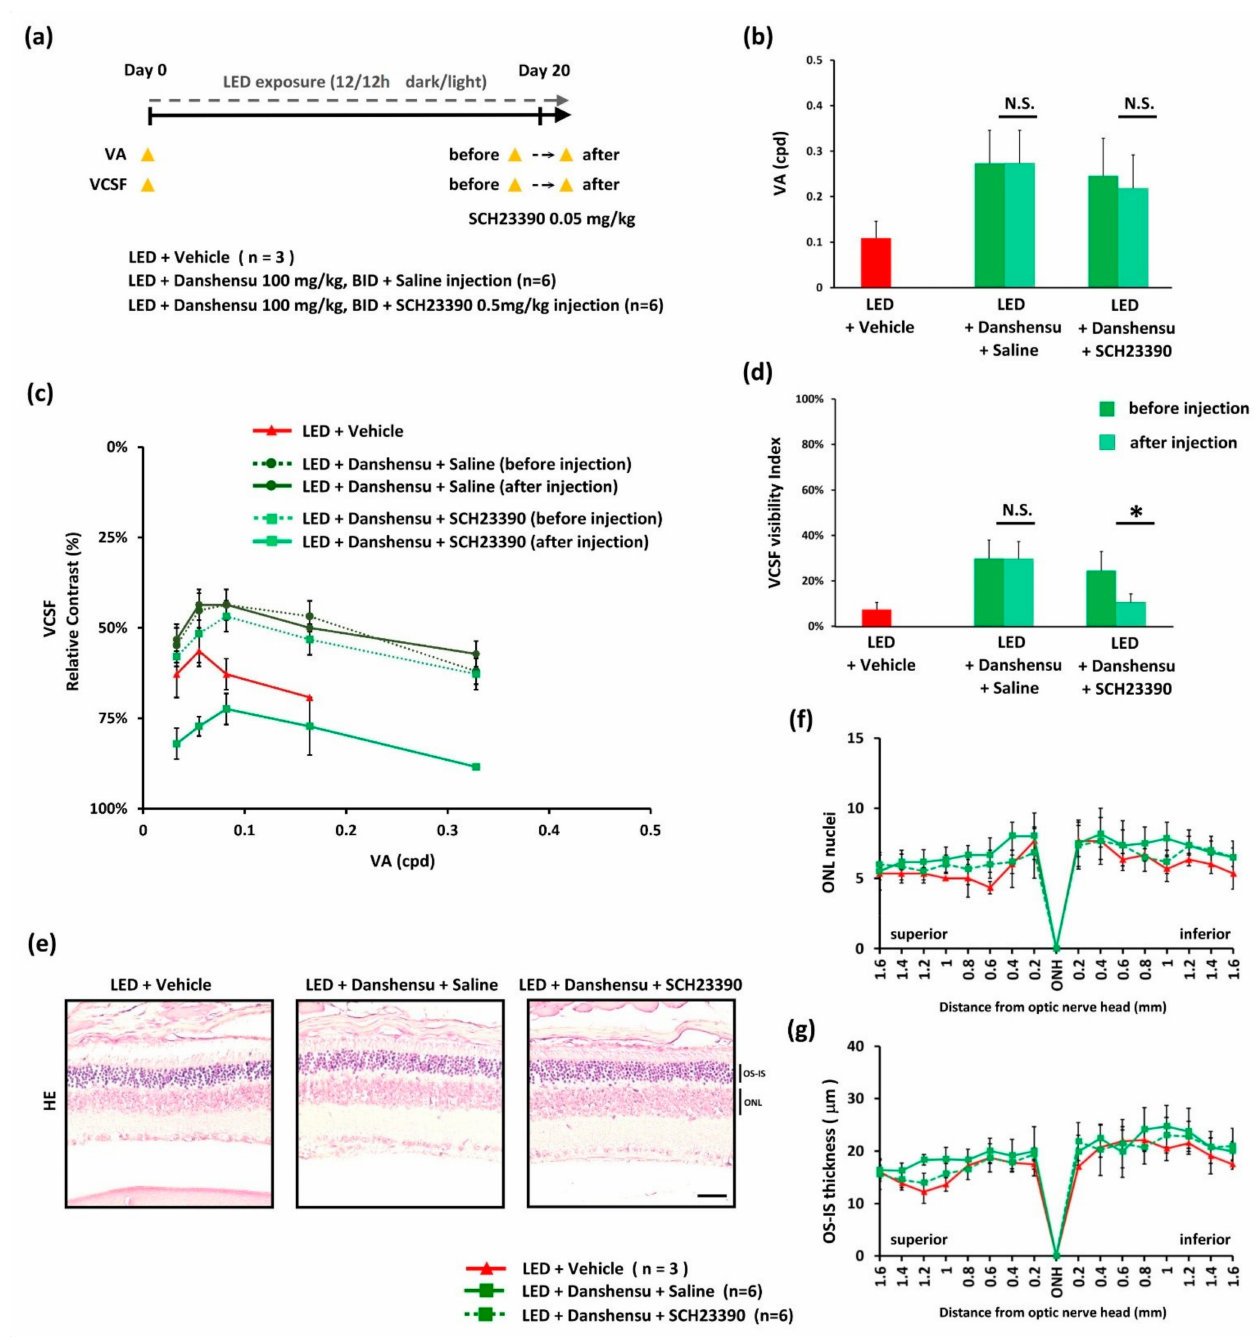
Figure 5. Effect of danshensu on the modulation of dopamine receptor to improve VCSF. ( a ) Timeline of experimental design; ( b ) Representation of the change in VA threshold; ( c ) Change in VCSF threshold; ( d ) Change in VCSF visibility index after dopamine D1 receptor antagonist (SCH 23390) injection; ( e ) Representation of the absence of difference after H&E staining; ( f ) Residual thickness of ONL ( g ) and OS-IS after SCH 23390 injection. Data are expressed as mean ± SE. Mann–Whitney U test, N.S., non-significant. * p < 0.05, compared with the vehicle group. Scale bar: 35 µ